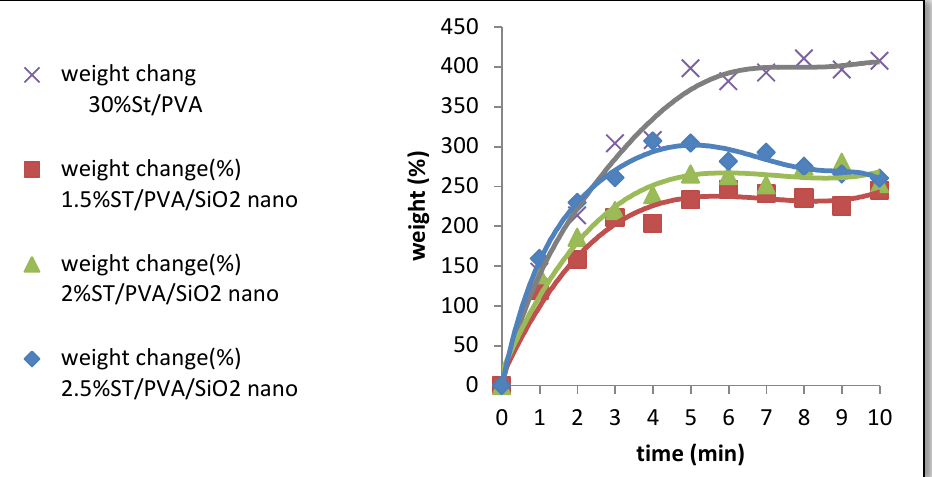
Fig. 3: Water absorption of nano SiO